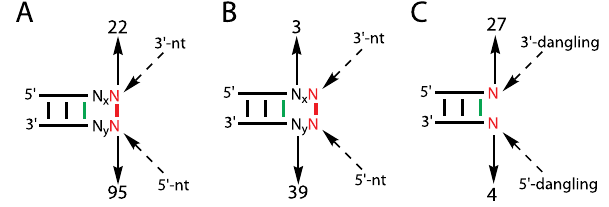
Figure 4. Preferred tertiary contact sites around helix capping basepair motifs and favored C 9 -capping. ( A ) Tertiary contacts favoring the 5 9 -nt over the 3 9 -nt; ( B ) Tertiary contacts favoring the 5 9 - IVS over the 3 9 -IVS; ( C ) C 9 -capping favoring 3 9 to canonical helices. While N={A, C, G, U}, x and y are any integer greater than or equal to zero. As in Figure 1, while helix ends are in green, helix capping motifs are in red.